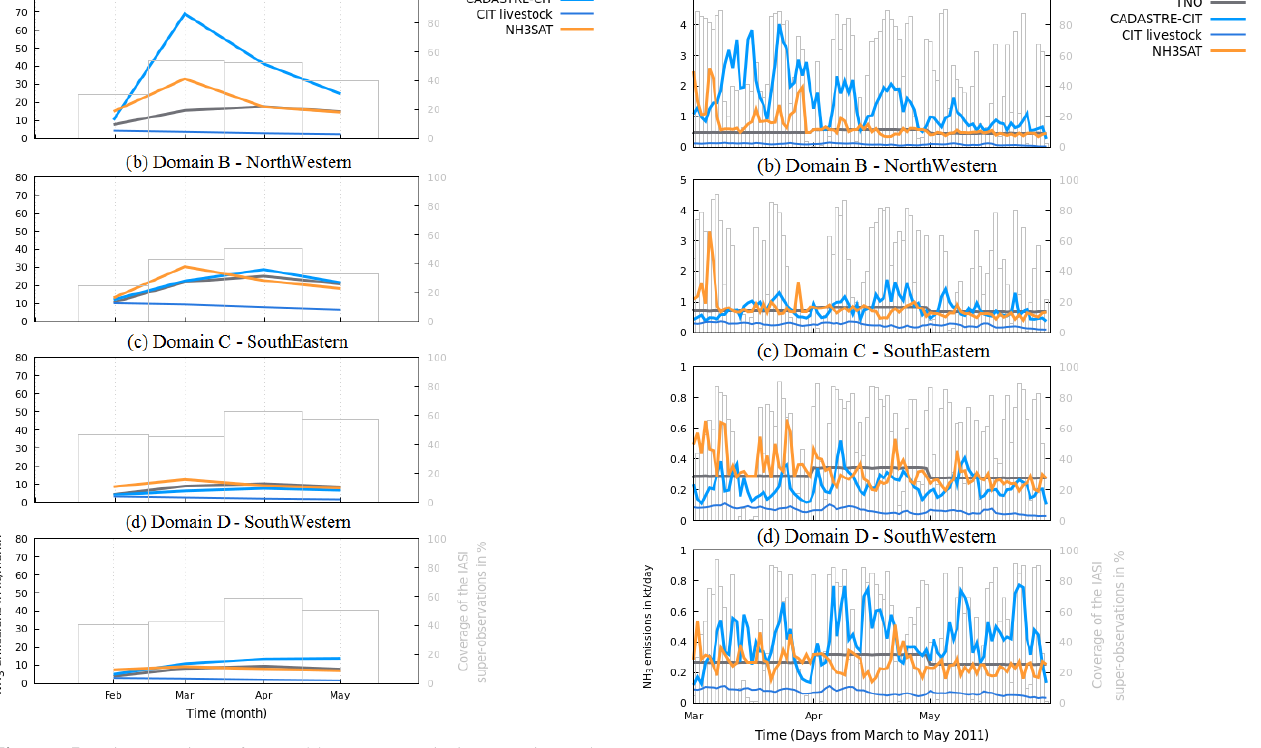
Figure 6. Time series of daily NH 3 emissions estimated by TNO- GEN (in black), by NH 3 SAT (in orange) and by CADASTRE-CIT (in blue) inventories, from March to May 2011, for (a) domain A (northeastern), (b) domain B (northwestern), (c) domain C (south- eastern) and (d) domain D (southwestern), as defined in Fig. 2. Note that the scale is different between (a,b) and (c,d) . Units are kilotons of NH 3 per day (ktNH 3 d − 1 ). The contribution of the emissions due to livestock in the CADASTRE-CIT daily variability is also given. The daily regional coverage of the IASI super-observations is given in percentage (in